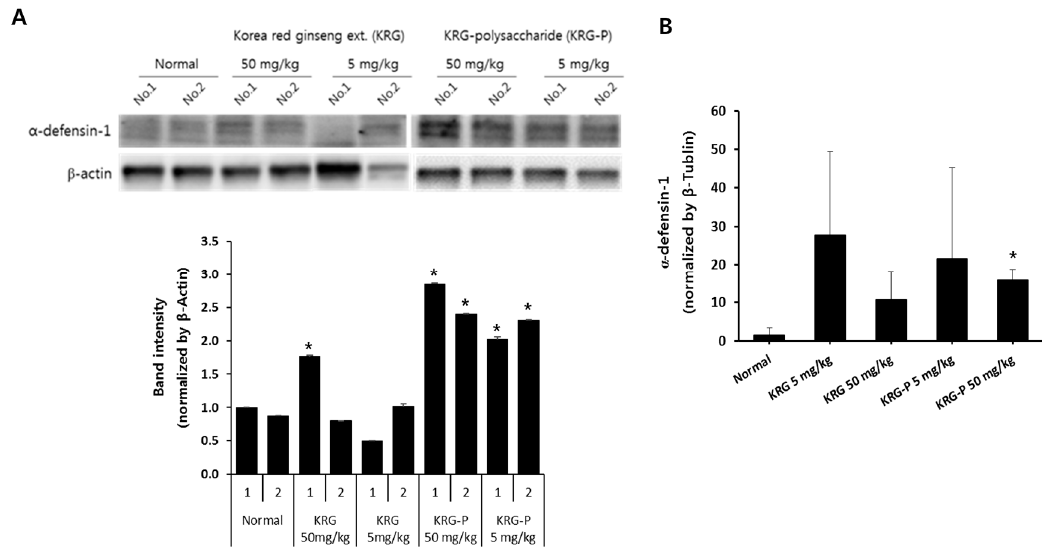
Figure 4. Effects of oral administration of KRG and KRG-P on α -defensin-1 expression in mouse intestinal tissues. BALB / c mice were orally administered the indicated doses of KRG or KRG-P daily for 10 days. ( A ) e α -defensin-1 protein levels were determined by immunoblotting with the specific antibody. Actin was used as a loading control. The bar chart displays the intensity of α -defensin-1 after normalizing with that of β -actin by using ImageJ software. ( B ) α -defensin-1 mRNA levels were determined by using qRT-PCR. An actin gene was used as a housekeeping gene for normalization. Data are presented as the means ± SD of three independent experiments. * p < 0.05 vs. the normal group.